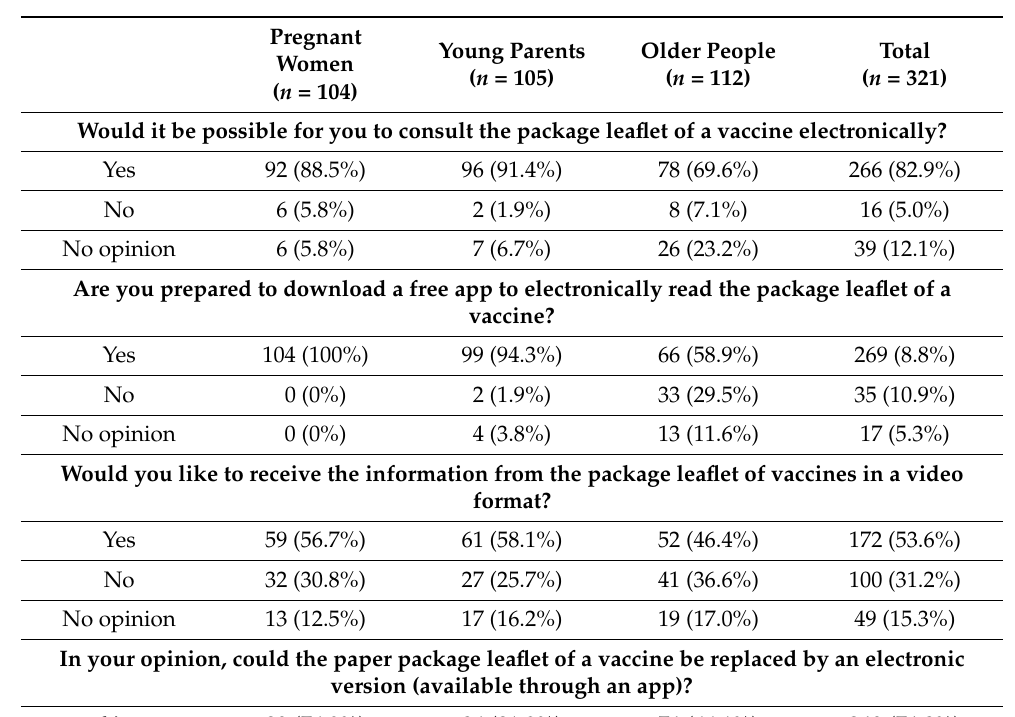
Table 4. Overview of the answers of the respondents about the possibility of switching to an e-leaflet, shown for the three target